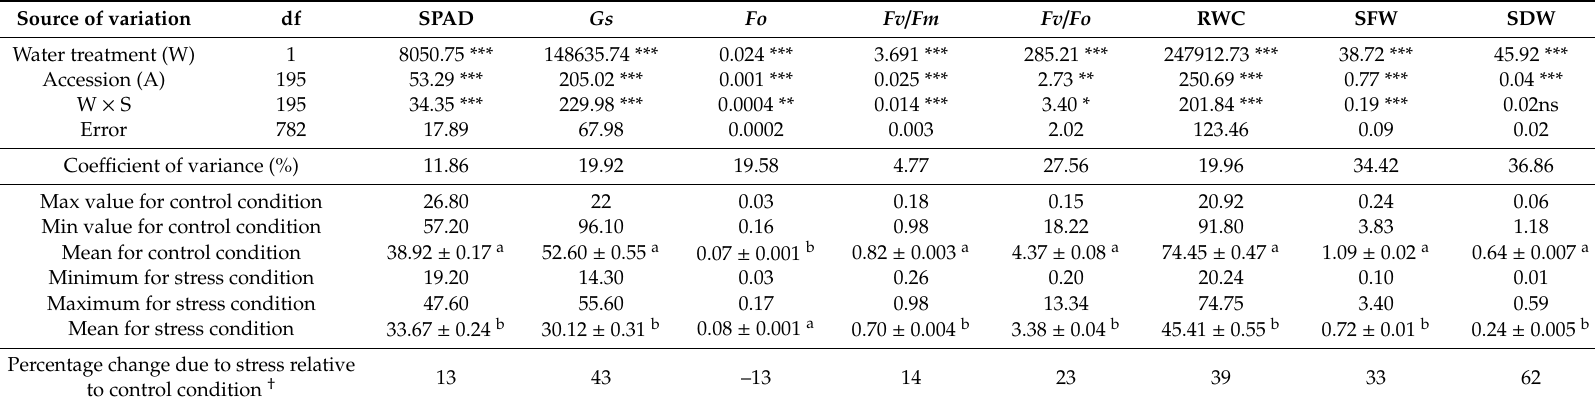
Table 1. Analysis of variance (ANOVA) for shoot biomasses, physiological traits and chlorophyll fluorescence parameters in 196 accessions with the D genome. Source of variation df SPAD Water treatment